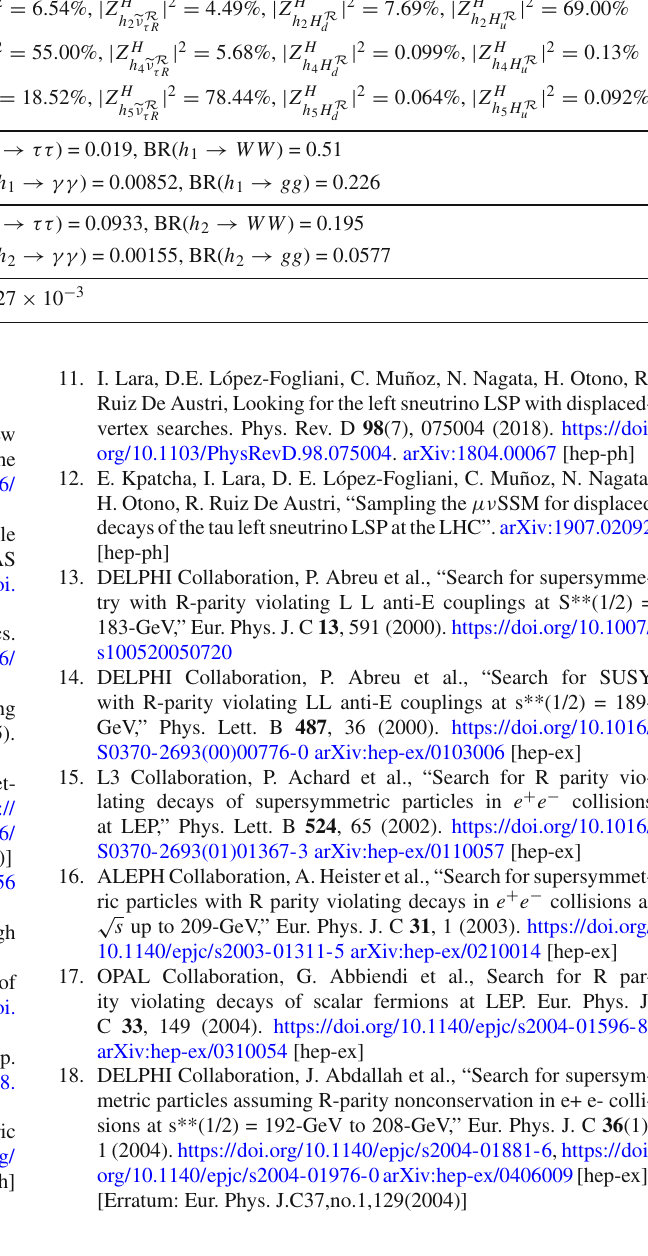
Table 15 The same as in Table. 12, but for the benchmark point S3-2h2 with several singlet-like scalars h 1 , 4 , 5 of masses close to the mass of the SM-like Higgs h 2 . the branching ratios of h 2 , and h 1 which contributes to the superposition of signals, are shown in the sixth and seventh boxes, and their decay widths in the eight